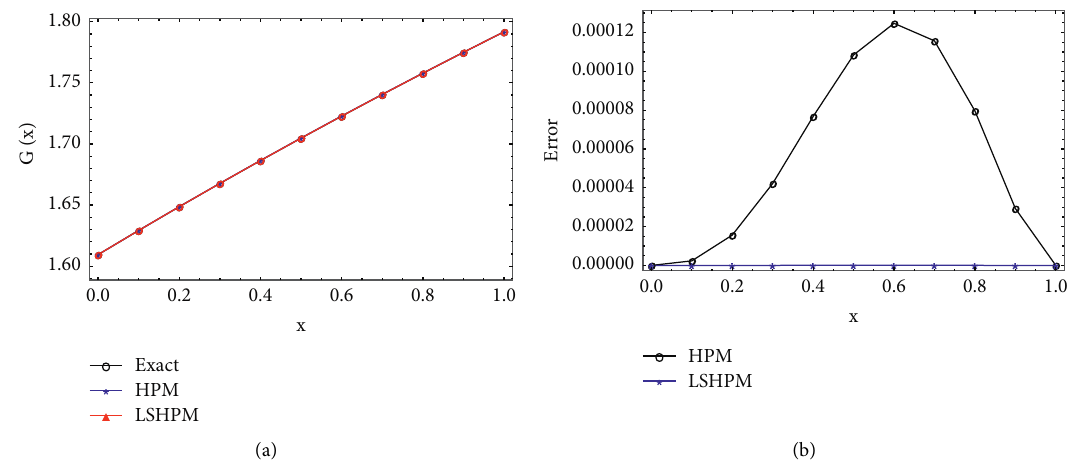
Figure 8: Graphical representation of solutions and errors in Problem 8. (a) Comparison of Exact, HPM, and LSHPM solutions. (b) Comparison of absolute errors of HPM and LSHPM.